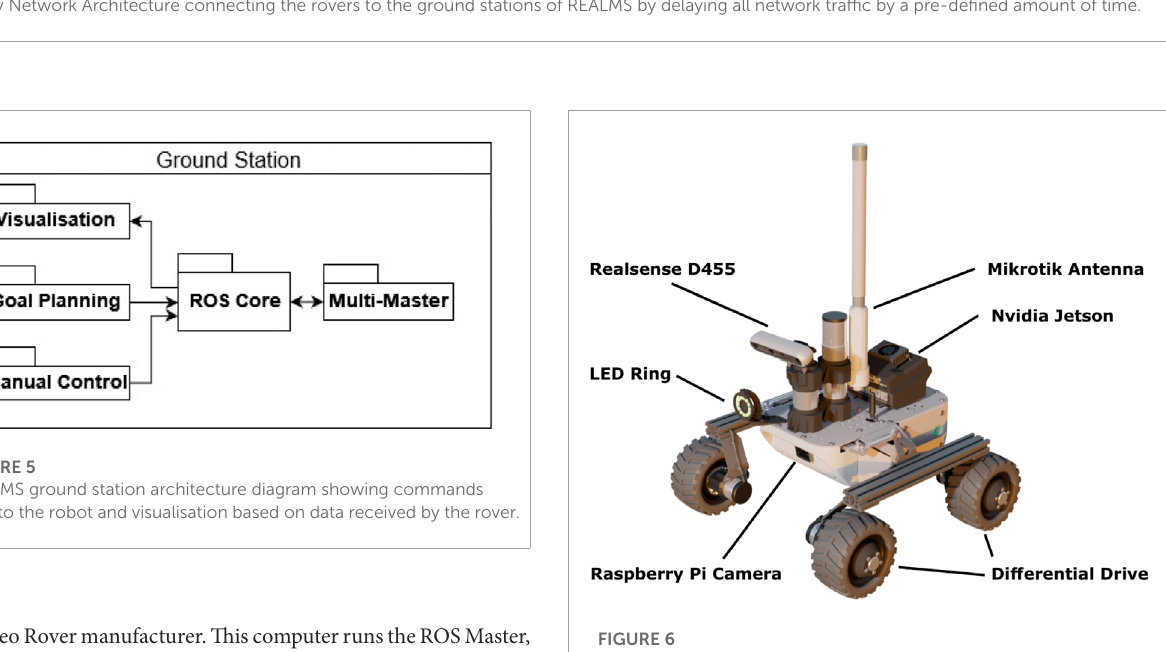
FIGURE 6 Overview of the REALMS Leo Rover